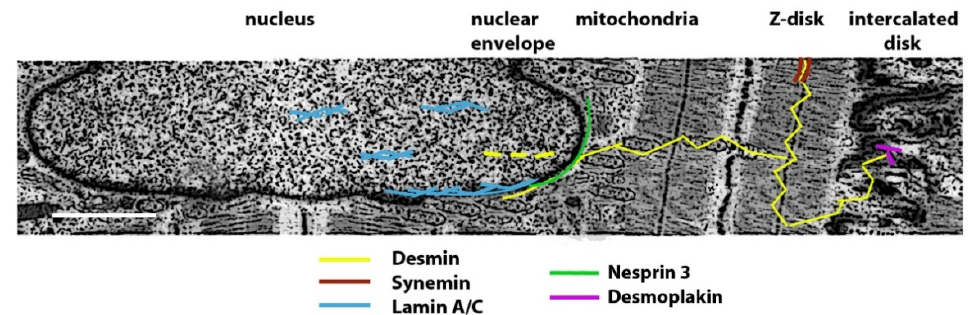
Figure 1. Schematic representation of intermediate filament proteins desmin, lamin A/C and synemin distribution in myocardium. Desmin connects the Z-disks with the intercalated disks, mitochondria, lysosomes (not shown here) and the nuclear periphery. Synemin binds desmin at costameres (not shown here), the membrane units at the Z-disks. Desmoplakin connects desmin to plakoglobin at the intercalated disks. Nesprin 3 binds desmin at the nuclear periphery of cardiomyocytes. Lamin A/C is localized at the nuclear lamina, beneath the inner nuclear membrane and connects to nesprin 3 in the LINC complex (see text). Lamin A/C is also localized in the nucleoplasm. Desmin can transiently enter the nucleus (dotted yellow lines) in cardiac stem cells and interact with transcription factors [16]. In skeletal muscle, similar interactions are established at the Z-disks, mitochondria, lysosomes and costameres between desmin, lamin A/C or synemin and their binding partners [14]. Scale bar, approx. 1 μ m.